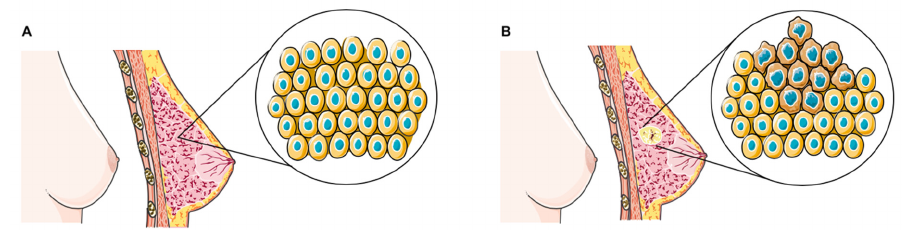
Figure 1. Representative image of a macroscopic and microscopic view of the breast and its tissue. ( A ) Healthy breast and tissue. ( B ) Breast with a tumor, only visible on a microscopic view. Images are modified from Servier Medical Art (https://smart.servier.com accessed on 20 December 2020).